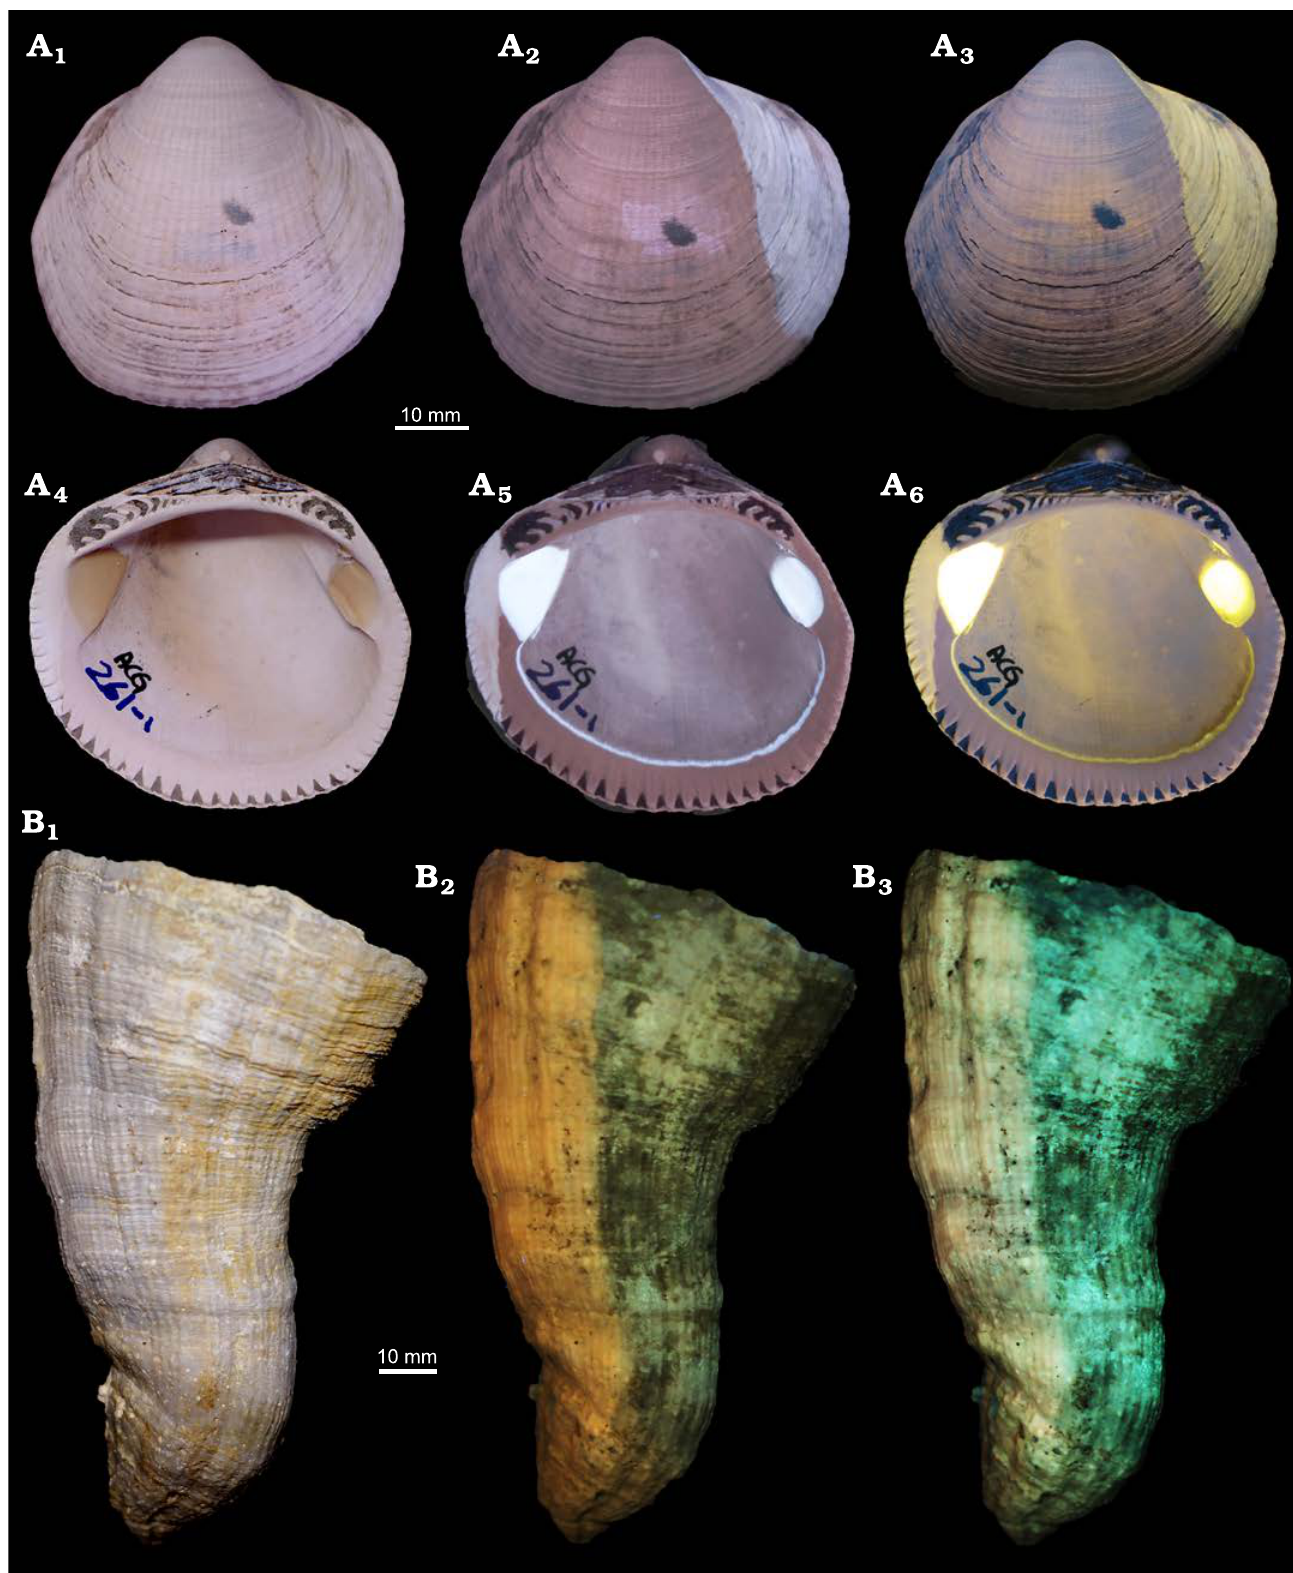
Fig. 4. Bivalves photographed under visible, UV, and VV light. A . Arcoid bivalve Glycymeris nummaria (Linnaeus, 1758) from the Lower Pleistocene Arda River section, Italy. MPUM 12162 (ACG261-1), right valve in external (A 1 –A 3 ) and internal (A 4 –A 6 ) view, visible light (A 1 , A 4 ), 365 nm (A 2 , A 5 ) and 440 nm (A 3 , A 6 ). B . Hippuritid bivalve Vaccinites sp. from the Upper Cretaceous Samhan Formation, Oman. MPUM 12167 (OMAN-1), conical valve, visible light (B 1 ), 365 nm (B 2 ) and 440 nm (B 3